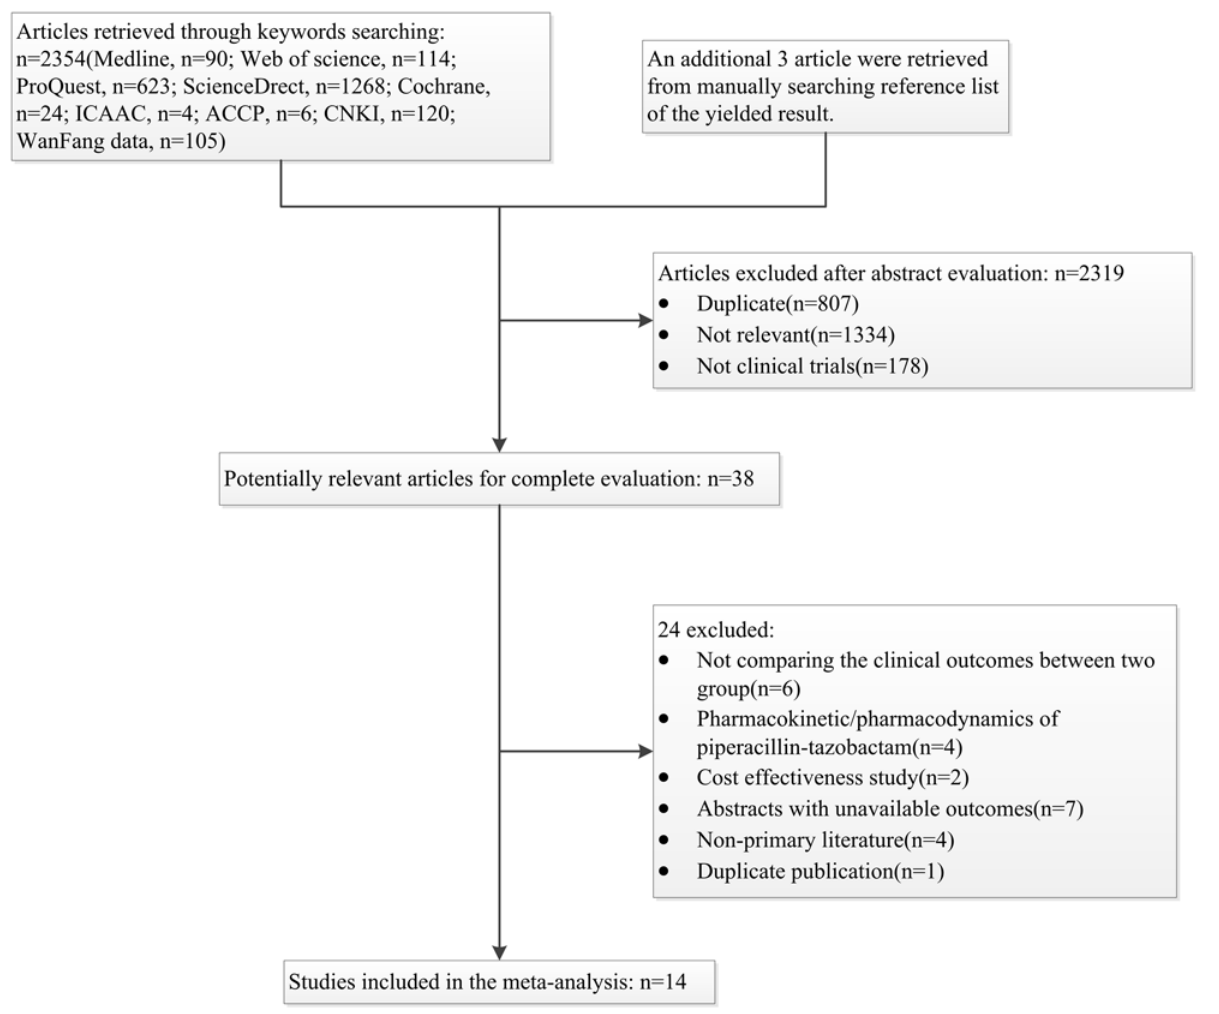
Figure 1. Flow chart depicting the selection process of studies included in the